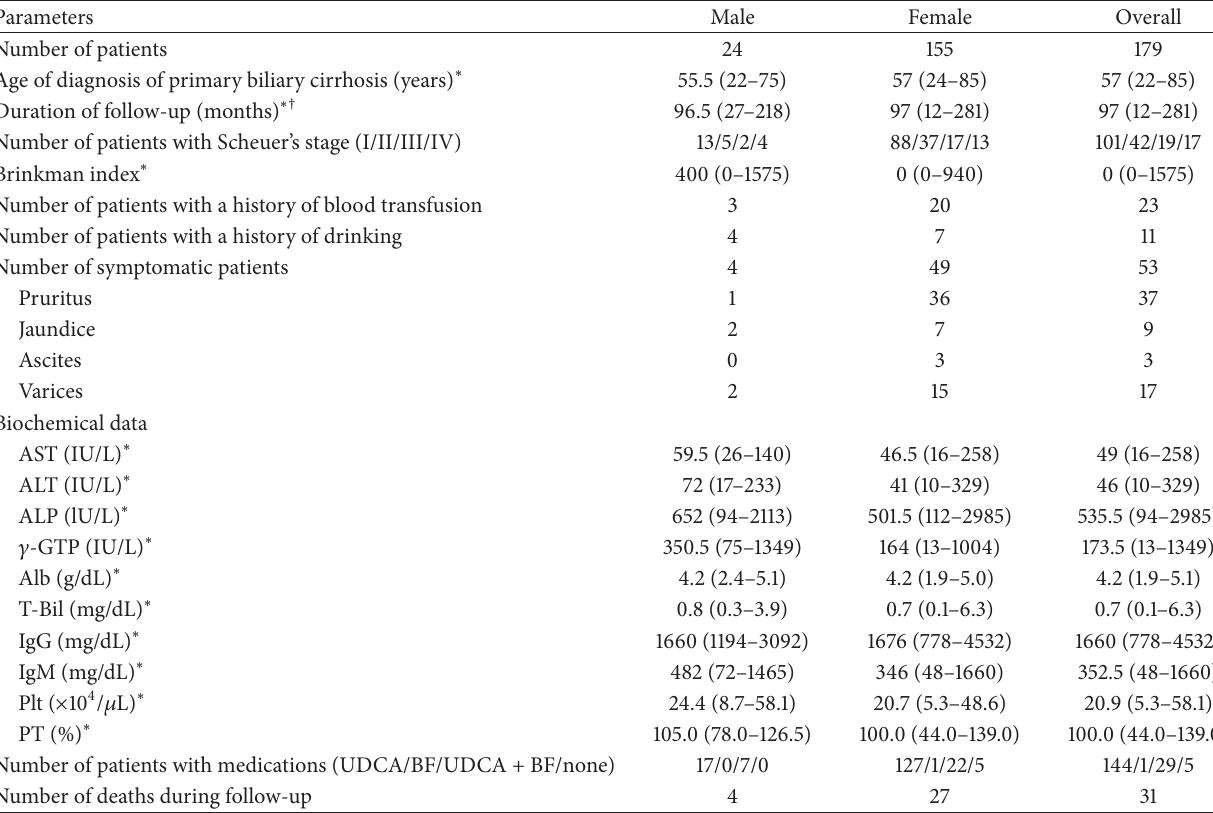
Table 1: Clinicopathological characteristics of the study